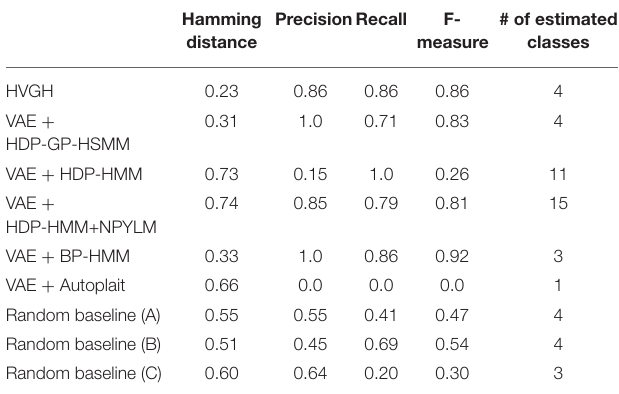
FIGURE 16 | Hamming distance of each method.